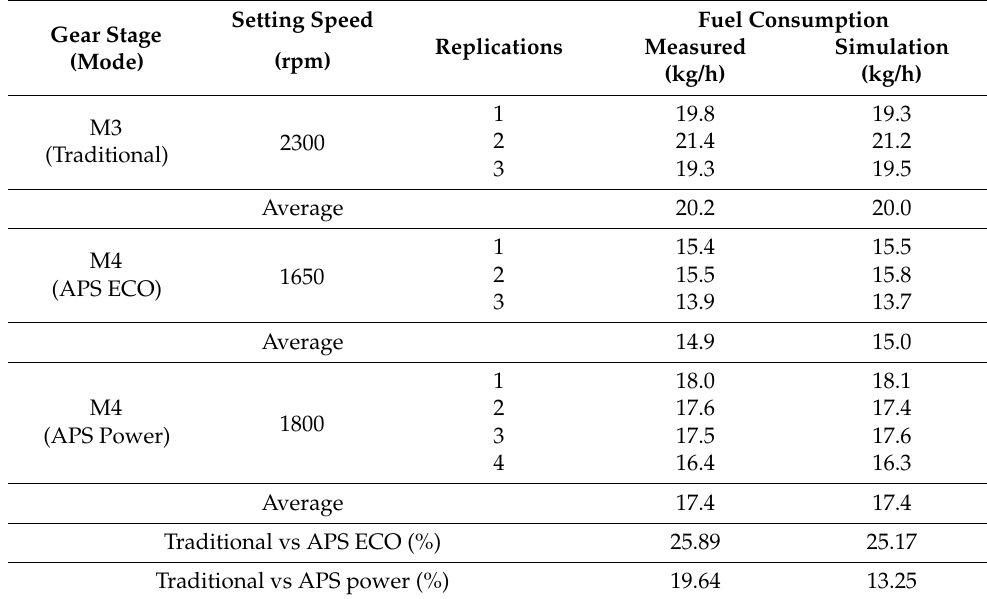
Table 6. Fuel consumption analysis during plow